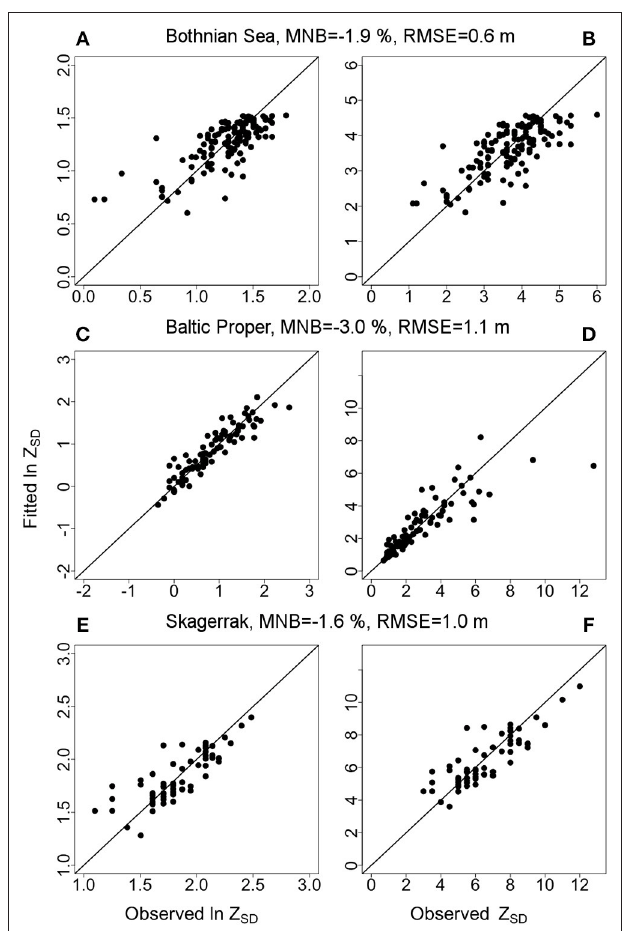
FIGURE 5 | Graphs showing the observed Secchi depth, Z SD (m) on the x-axis vs. fitted Secchi depth, Z SD on the y-axis for the main models per region. The left panel (A,C,E) shows the values in natural log scale and the right panel (B,D,F) in back-transformed normal scale. The Mean Normalized Bias; MNB and Root Mean Square Errors; RMSE are indicated for each model. Graphs for the additional models are shown in the Figure S4